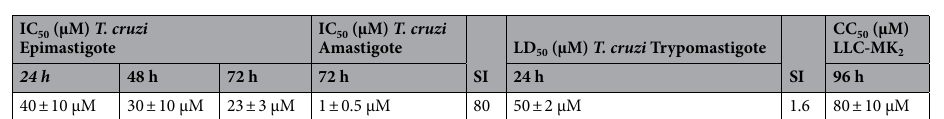
Figure 1. T. cruzi epimastigotes proliferation and viability in the presence of FEX. ( A ) Epimastigote proliferation was strongly inhibited for up to 72 h of treatment. ( B ) The percentage of parasites after 72 h in the presence of the drug (i.e., 96 h of growth) indicates that the most effective concentrations were 30, 40, and 50 µM. ( C ) After removal of the drug from the medium, the percentage of parasites indicates an increase in the number of epimastigotes. ( D ) Epimastigote viability after 72 h of treatment. The percentage of viable parasites was similar, except in the presence of 50 µM. The data are the average of three independent experiments in triplicate (***p < 0.001).